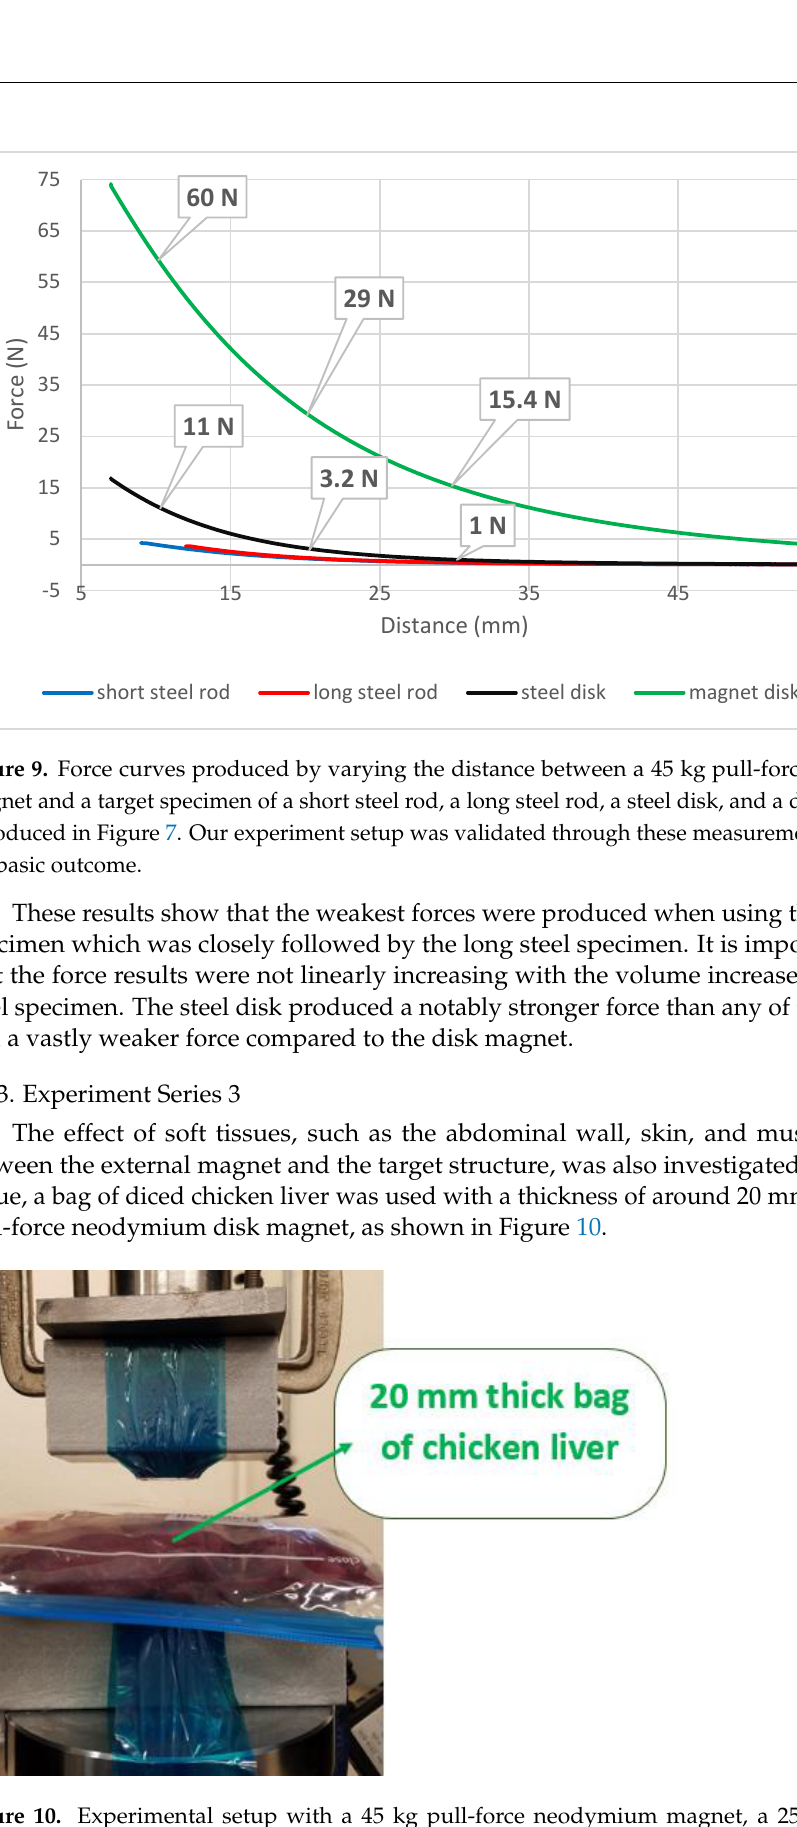
Figure 10. Experimental setup with a 45 kg pull-force neodymium magnet, a 25 kg pull-force neodymium magnet as the target specimen, and a 20 mm-thick bag of diced chicken liver in